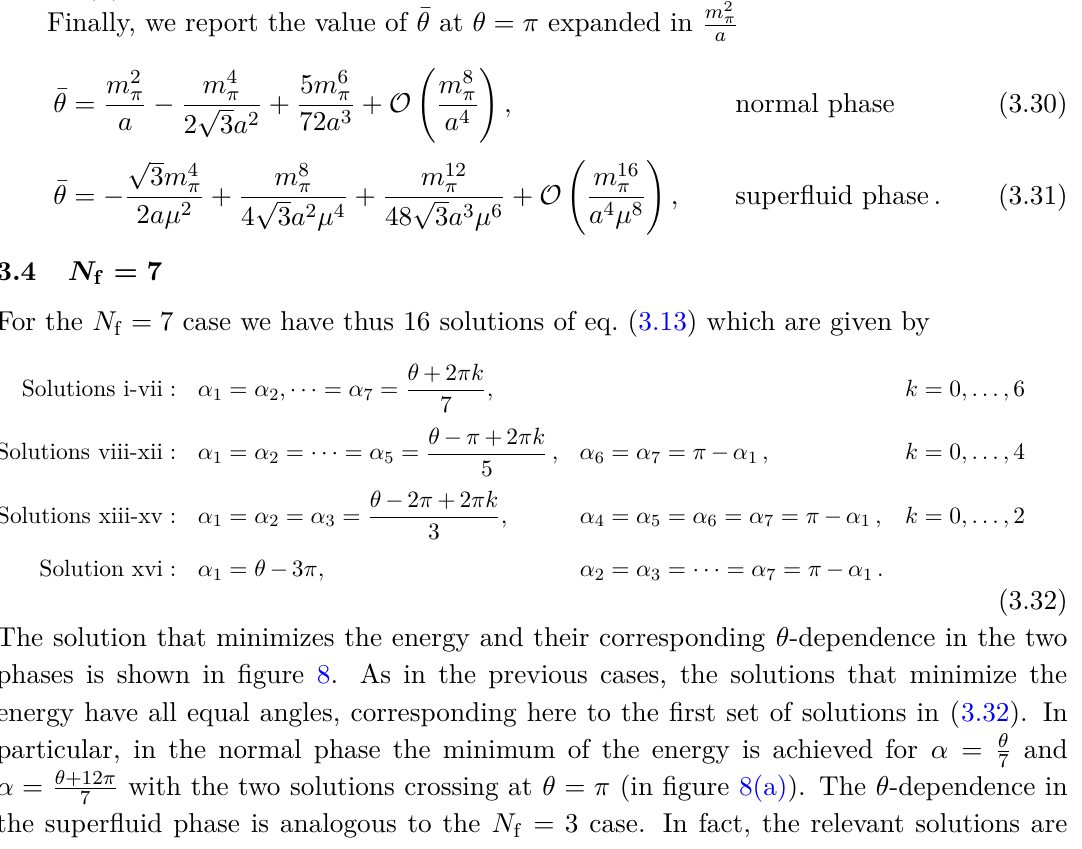
(a) The CP order parameter (cid:10) F ˜ F (cid:11) as a func- tion of θ in the normal phase. Figure 7 . θ -dependence of the CP order parameter for N f = 6